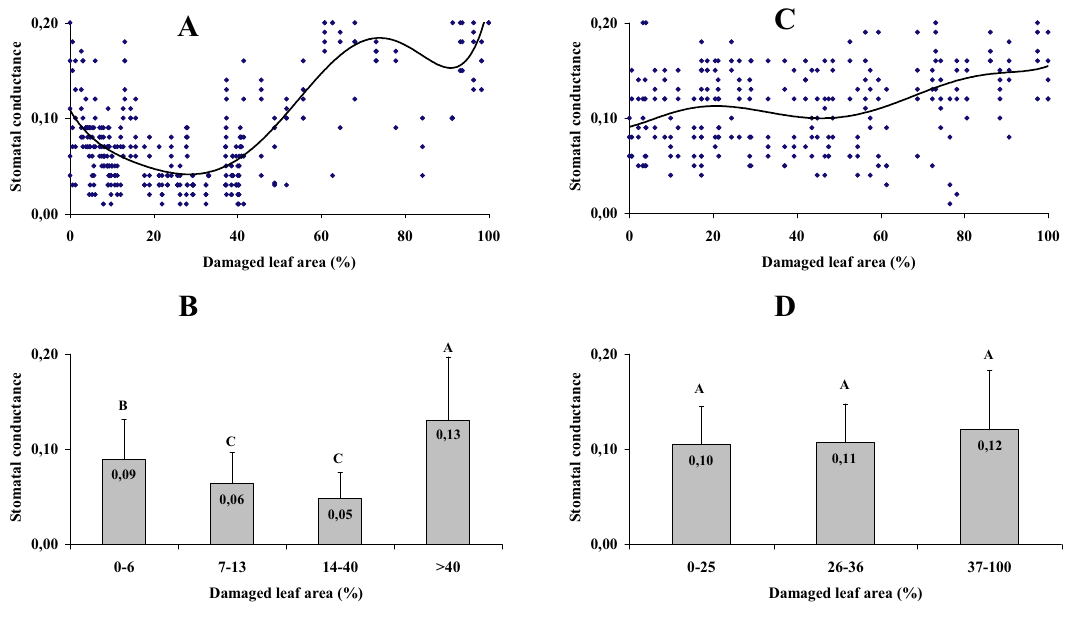
Fig. 4 – Effect of leaf area damaged (0 to 100%) by O. praelonga and L. coffeella on stomatal conductance (mol H 2 Om − 2 s − 1 ) . Effect of O. praelonga infestation intensity at four intervals, on stomatal conductance of lime leaves (A and B) and of L. coffeella at three intervals, on Obatã coffee leaves (C and D). Treatments followed by the same letter do not differ by Tukey test, at 5% probability.